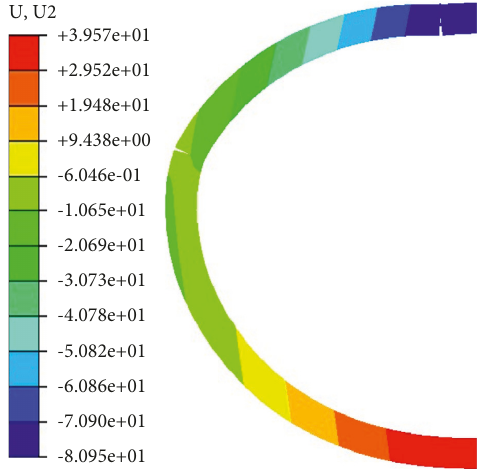
Figure 8: Vertical displacement contour at the reinforcement point (unit: mm).